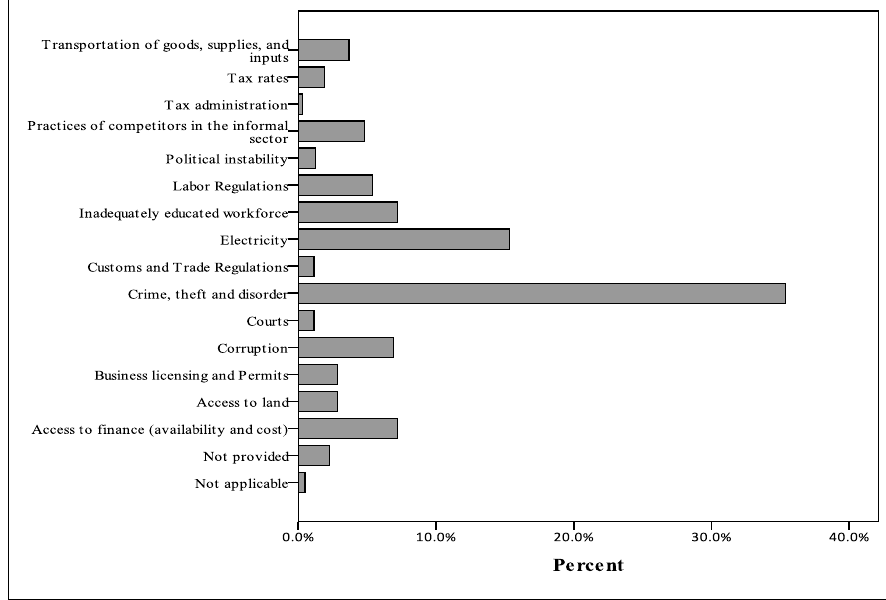
FIGURE 1: Obstacles to operations